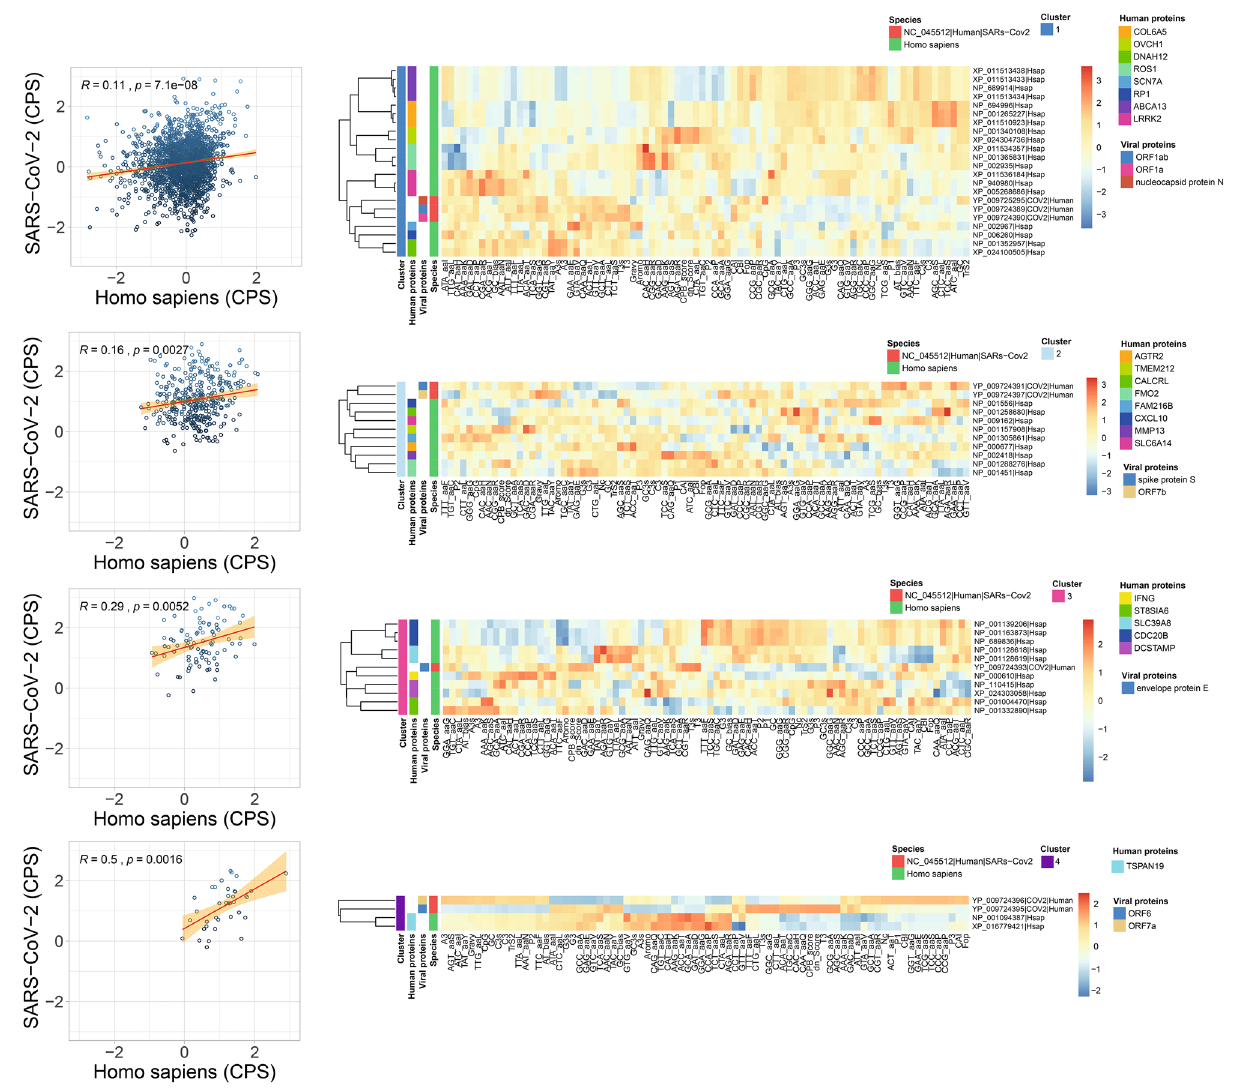
Figure 3. Heatmap of clusters (1–4) using a hierarchical method of viral genes for SARS-CoV-2 (NC_045512) of the human host and human genes based on the molecular features. CPB correlation is included in the left for each cluster relating the CPB of human genes (horizontal axis) and CPB of the viral genes (vertical